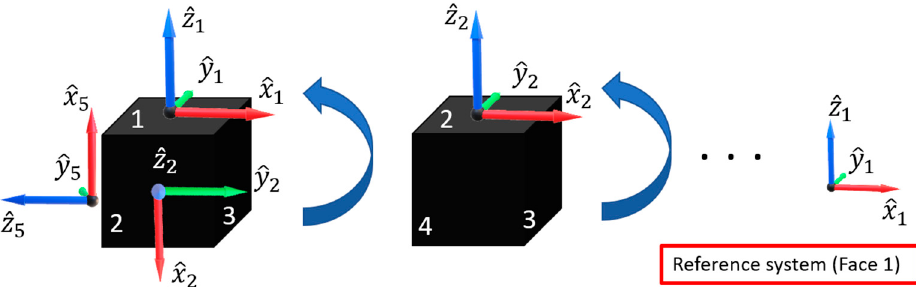
Figure 3. Operations of sensing axes alignment procedure.